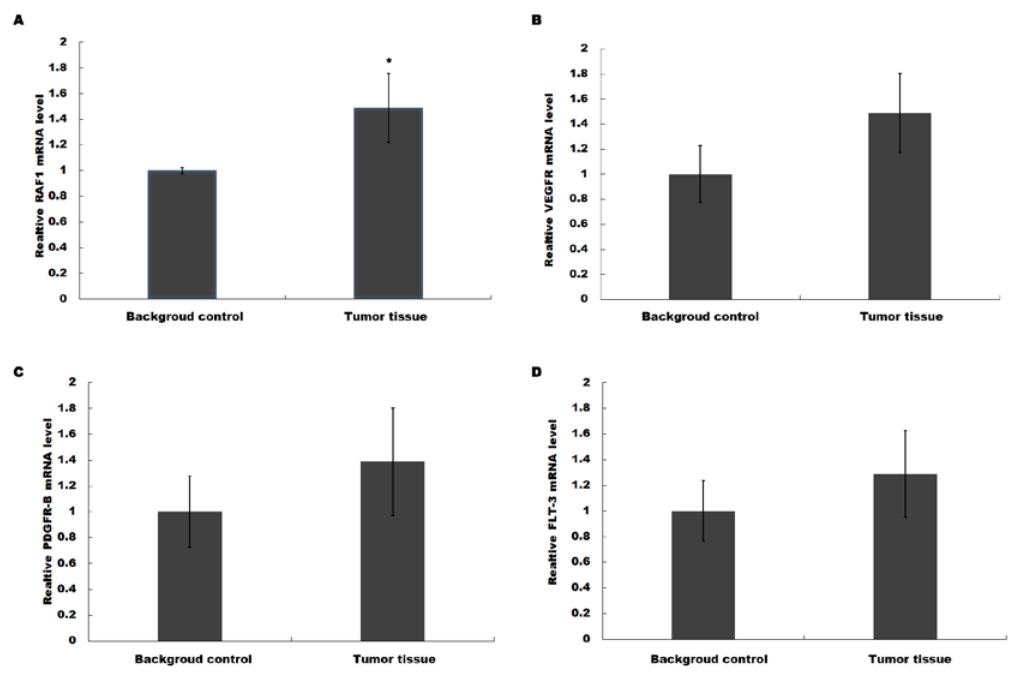
Figure 3 : RAF1 expression was increased in HCC patients. Several widely recognized oncogenes were determined by Realtime qPCR, inclu- ding RAF1 (A), FLT-3 (B), VEGFR (C) and PDGFR-B (D), which were commonly regarded as useful targets of sorafenib. RAF1 mRNA level showed a highly significant enhancement. ** p<0.01 HCC vs